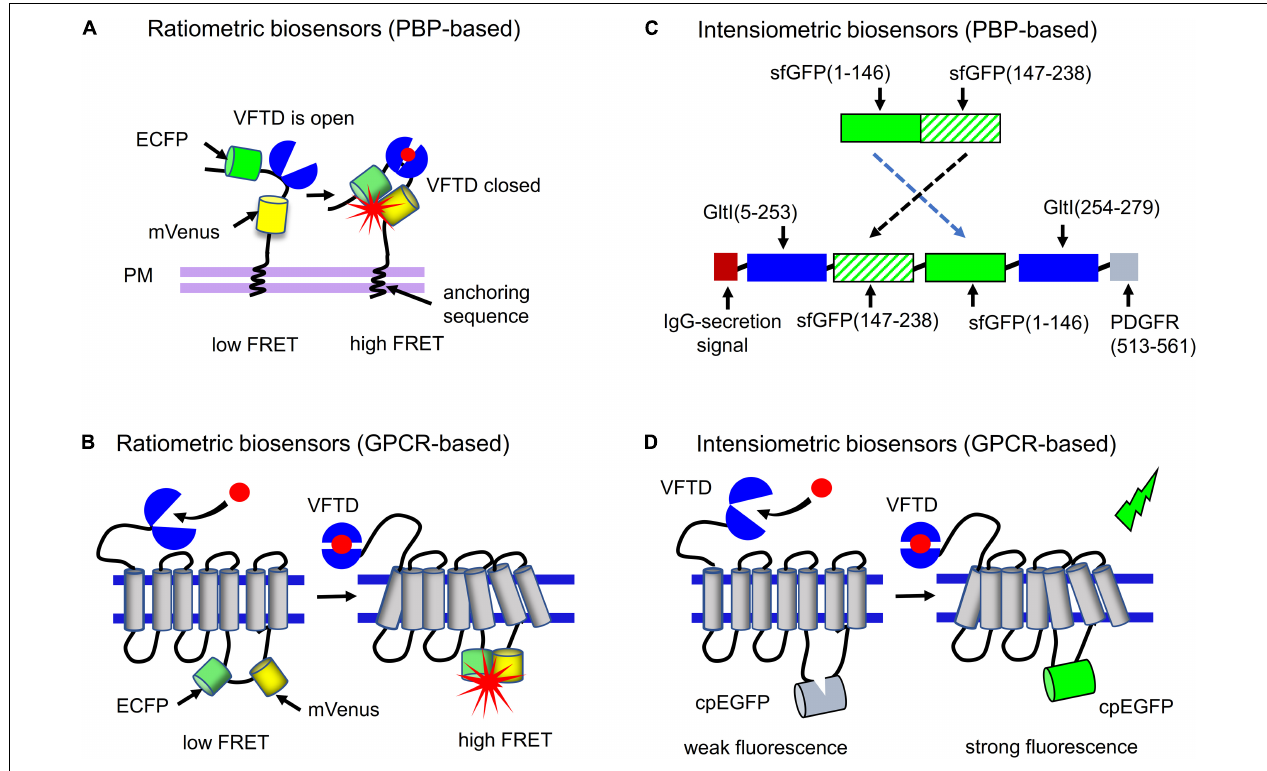
FIGURE 2 | Ratiometric and intensiometric biosensors. (A) FRET-based biosensors in which PBP proteins are used as neurotransmitter-sensing domains. A PBP is inserted between FRET pair of FPs, such as ECFP and mVenus. Upon PBP interaction with neurotransmitter the FRET efficiency between FPs changes, which can be detected. (B) FRET-based biosensors in which GPCR receptors are used as neurotransmitter-sensing domains. A FRET pair consisting of ECFP and mVenus is inserted in the third intracellular loop of the respective GPCR. Upon interaction of the receptor with neurotransmitter FRET between two FPs changes. (C) Example of the PBP-based intensiometric biosensor is shown. Circular permutant of superfolder GFP (sfGFP) between positions 146–147 is inserted into GltI protein, resulting in the SF-iGluSnFR glutamate biosensor (Marvin et al., 2018). N-terminal IgG-secretion signal ensures transport of the biosensor to extracellular space, while C-terminal transmembrane domain of PDGFR receptor anchors the biosensor to the plasma membrane (D) Example of the GPCR-A-based intensiometric biosensor is shown. Circularly permuted EGFP (cpEGFP) is inserted into the third intracellular loop of GPCR having the VFTD domain at the N-terminus. After